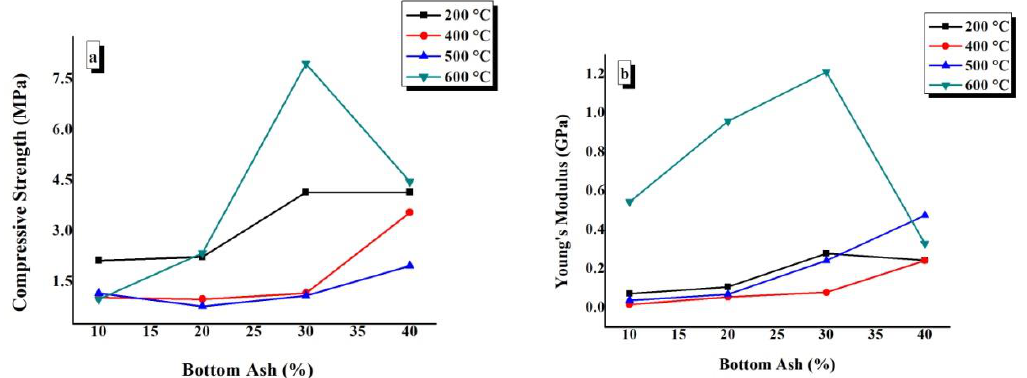
Figure 11. Effect of composition on the ( a ) compressive strength and ( b ) Young’s modulus of TGPFs at a constant curing temperature.